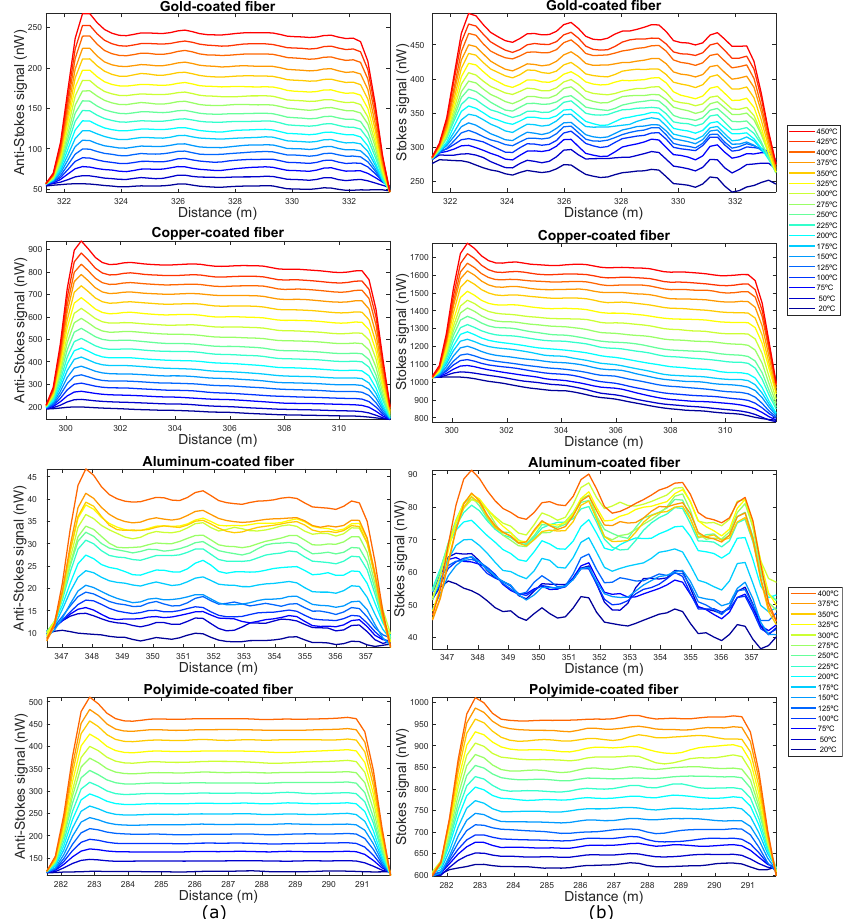
Figure 4. ( a ) Anti-Stokes and ( b ) Stokes signals obtained for gold-coated, copper-coated, aluminum-coated and polyimide/carbon-coated fibers (from top to bottom respectively) in the hot-spot zone.